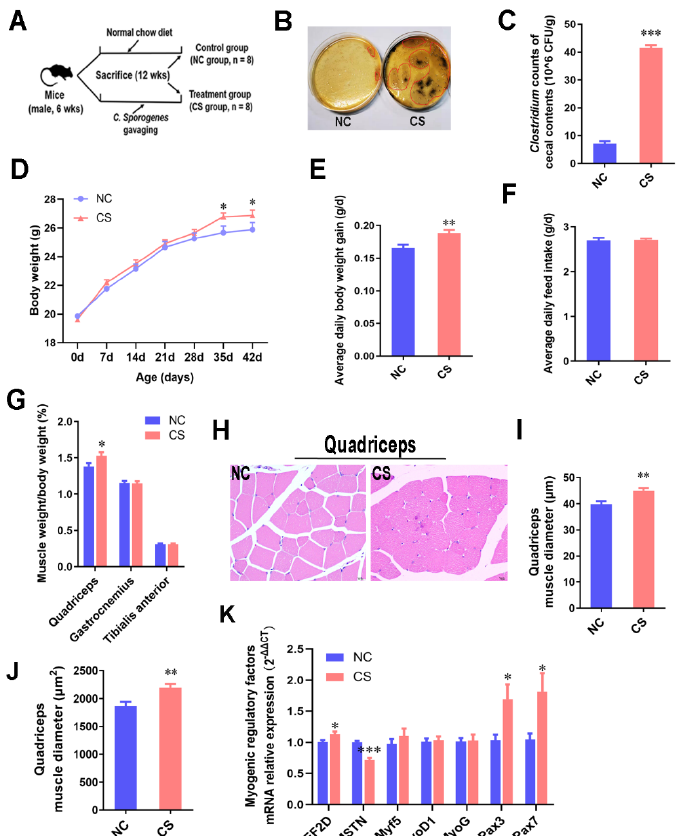
Figure 1. C. sporogenes supplementation promoted muscle weight gain by increasing myogenic regulatory factor signaling in mice. ( A ) Two groups of male C57BL/6 mice fed normal chow diet were administered bacteria culture media (NC group, n = 8) and C. sporogenes suspension, respectively (CS group, n = 8). ( B , C ) Plate counts of Clostridium genus colonization (black colonies circled in red) in the cecum after gavaging C. sporogenes for 42 days. ( D ) Body weights of C57BL/6 mice from 6 to 12 weeks of age. ( E ) Average body weight gain of the mice. ( F ) Average daily feed intake of the mice. ( G ) The ratio of muscle (gastrocnemius, quadriceps, and tibialis anterior) to the weight of mice. ( H – J ) HE staining of the quadriceps tissues in mice; the muscle fibers’ diameter ( I ) and muscle cross-sectional area ( J ) were measured. Scale bar = 10 μ m. ( K ) The mRNA expression levels of myogenic regulatory factors (MEF2D, MSTN, Myf5, MyoD1, MyoG, Pax3, Pax7) in the gastrocnemius tissue treated as described above. The data shown are the means ± SEM, n = 8. * p < 0.05, ** p < 0.01, and *** p < 0.001. Unmarked graphs show no significant difference.